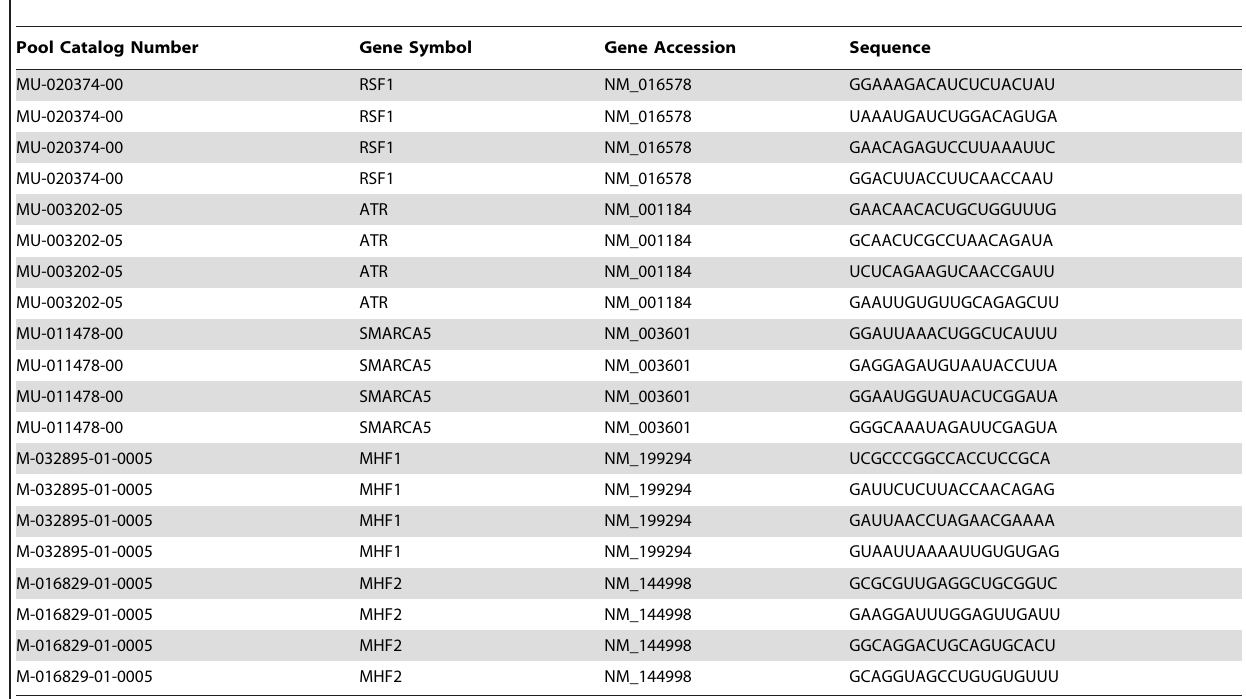
Table 2. siRNA sequences used in this